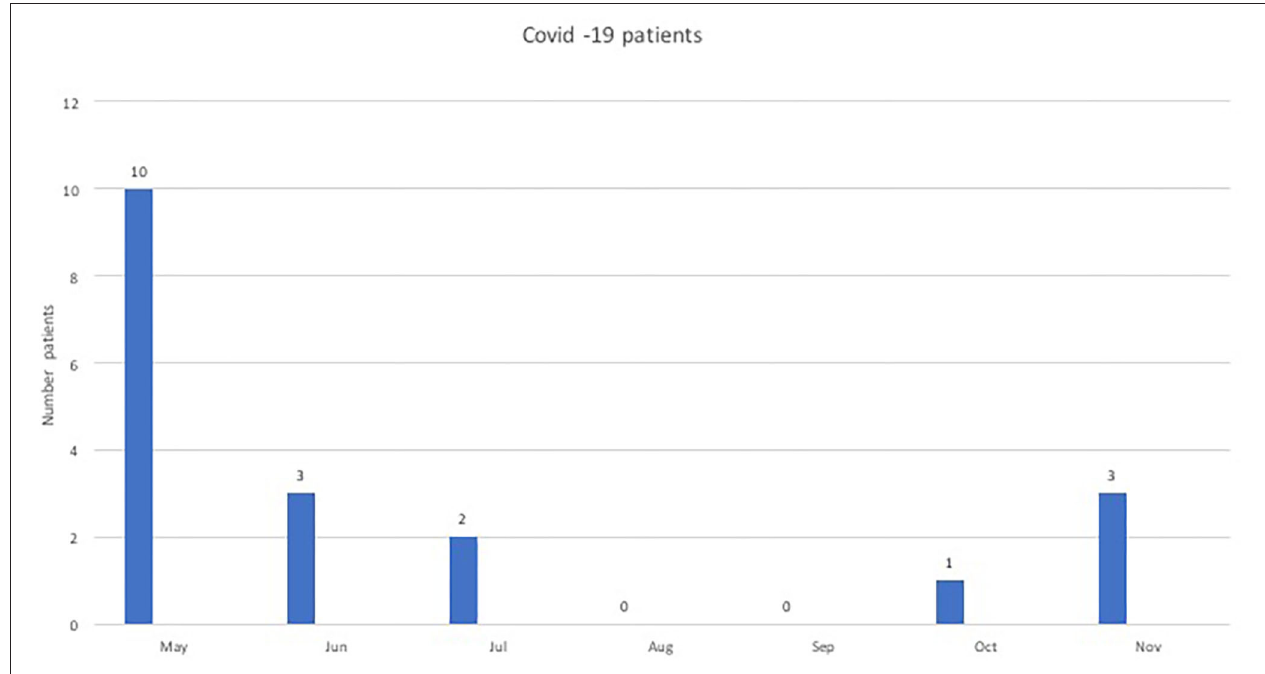
FIGURE 4 | Post-COVID19 patients admitted for rehabilitation.